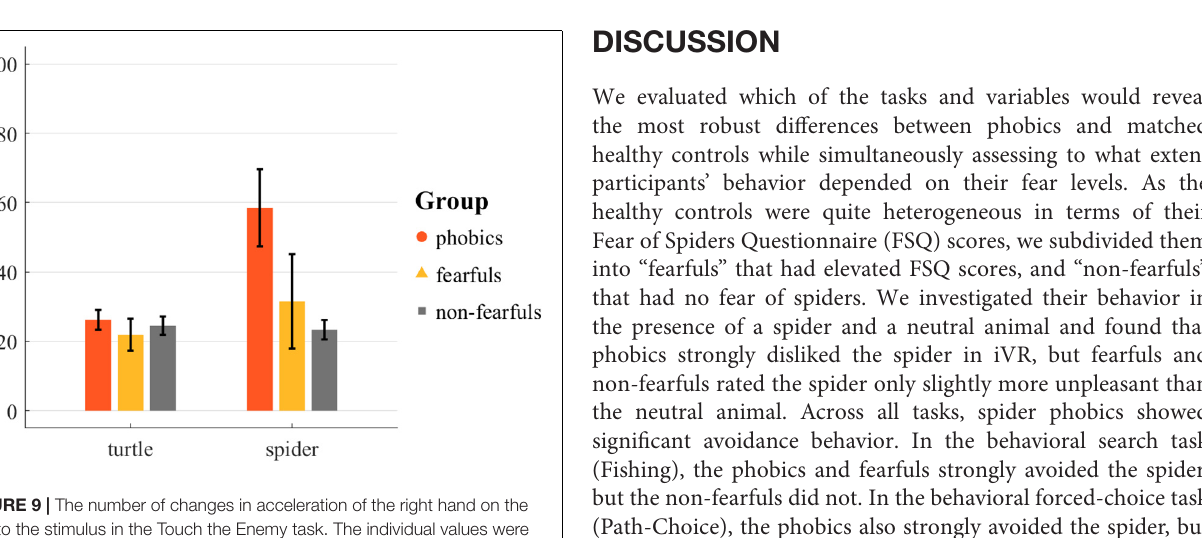
FIGURE 8 | Detailed analyses of the touch duration in the Touch the Enemy task: The duration in seconds the participants stayed on the way to the stimulus in each third. Individual values were truncated to 20 s. The rmANOVA revealed significant main effects of group, trial, stimulus, and area, and significant group × trial, group × stimulus, group × area, group × trial × area, stimulus × area, and group × stimulus × area interactions. Bars = group mean; lines = standard error.